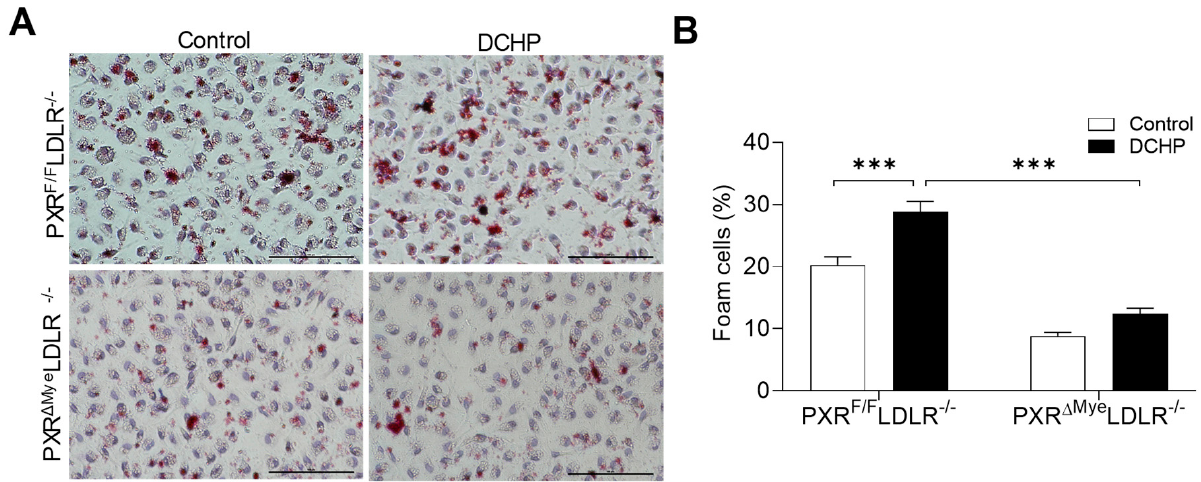
Figure 7. Ablation of PXR ameliorates DCHP-elicited lipid uptake by macrophages. Four-week-old male PXR F/F LDLR − / − and PXR ∆ Mye LDLR − / − littermates were fed a low-fat diet and treated by oral gavage with 10 mg/kg body weight of DCHP or vehicle control daily for 12 weeks. ( A ) Peritoneal macrophages were isolated and incubated with oxLDL (200 μ g/mL) for 24 h and stained with Oil Red O and hematoxylin (scale bars = 100 μ m). ( B ) Foam cell quantification from peritoneal macrophages in studies described in panel A. Data are represented as mean ± SEM (n = 3, *** p < 0.001).